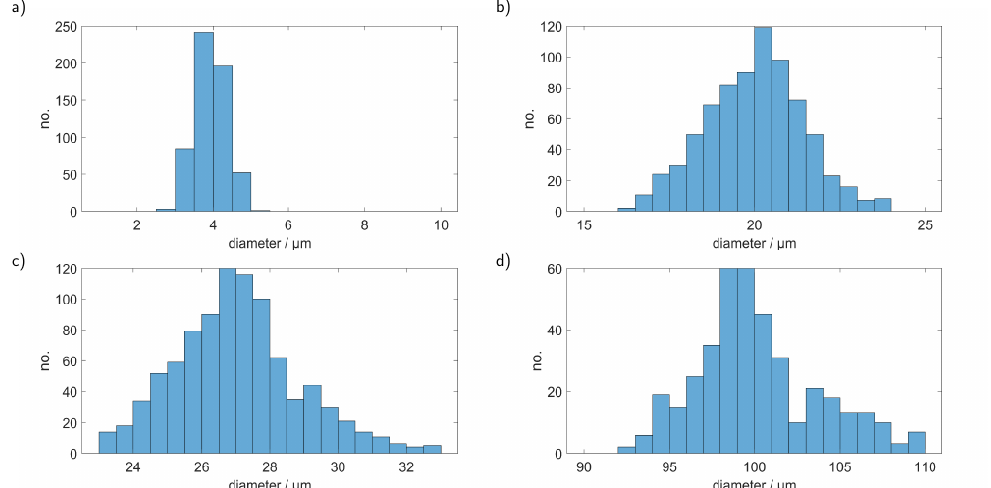
Figure 9. Determined sizes of PS particles with a diameter of ( a ) 4.21 µm, ( b ) 19.3 µm, ( c ) 26.15 µm and ( d ) 101